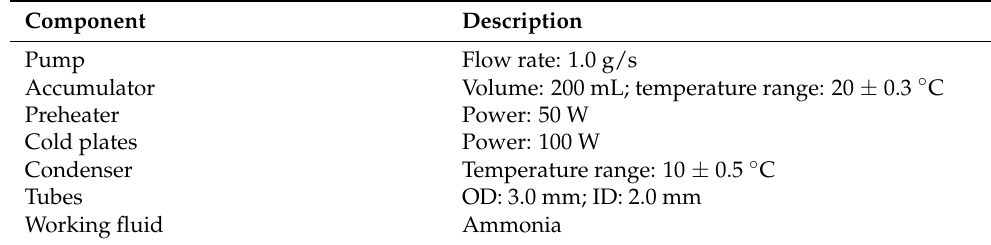
Table 1. Parameters of the MPTL system.